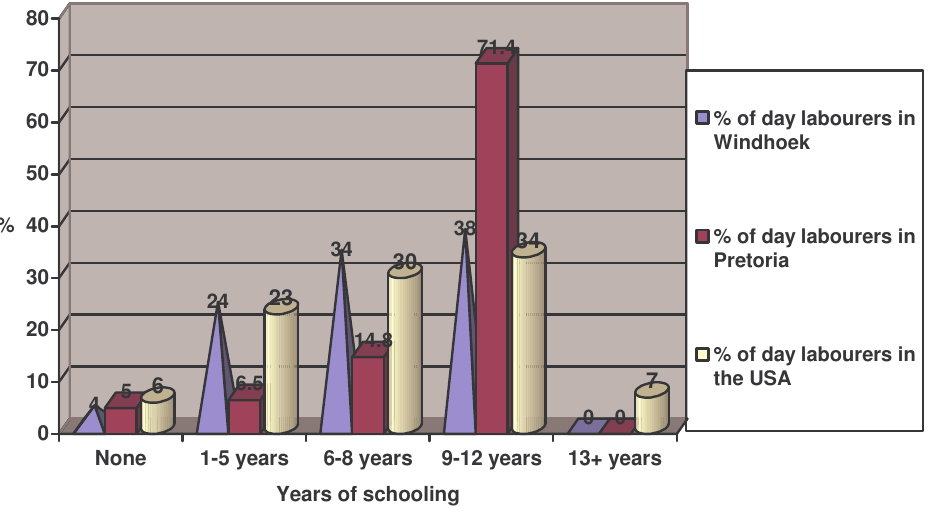
Figure 3: Years of schooling of day labourers in Pretoria in 2004, Windhoek in 2003 and the USA in